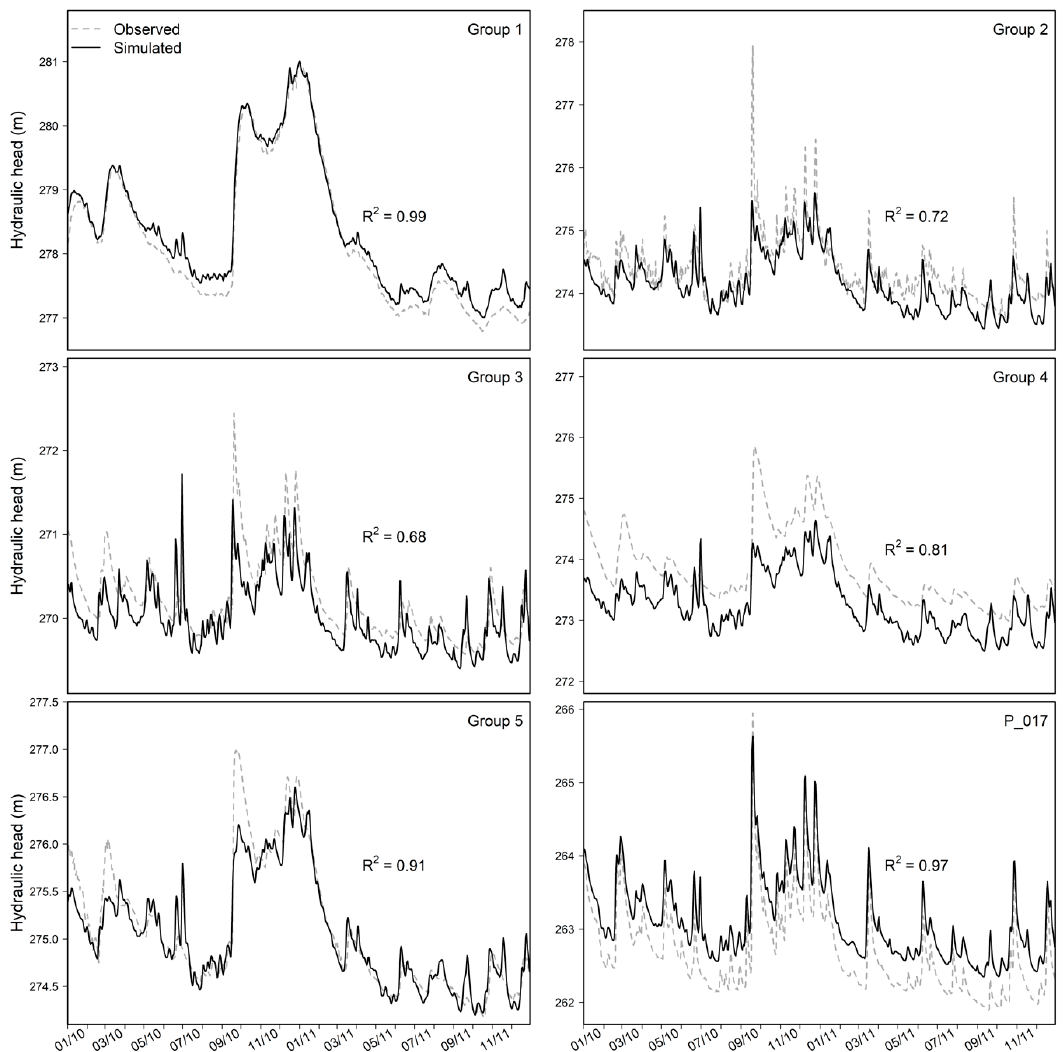
Figure 11. Observed and simulated hydraulic heads for the groups presented in Figure 2. Hydraulic heads were simulated in FEFLOW for the period 1 January 2010–31 December 2011.